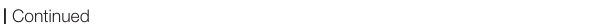
FIGURE 9 | Continued bilaterally directly before the start of light exposure (1st hour: PBS blue vs. yellow – q = 0.0008, p = 0.0008; oxybu blue vs. yellow – q < 0.0001, p < 0.0001; 3 h: PBS blue vs. yellow – q < 0.0001, p < 0.0001; oxybu blue vs. yellow – q = 0.0001, p = 0.0001). (B) Intraocular trigeminal afferents were anesthetized with lidocaine ( lido ). 2 µ L of drug was injected intravitreally ( ivt ) bilaterally 5 min before the start of light exposure (1st hour: PBS blue vs. yellow – q = 0.0007, p = 0.0006; 3 h: yellow PBS vs. lido – q = 0.0210, p = 0.0200; PBS blue vs. yellow – q = 0.0004, p = 0.0003). (C) Intraocular blood vessels were constricted with norepinephrine ( norip ). 2 µ L of drug was injected intravitreally ( ivt ) bilaterally 5 min before the start of light exposure (1st hour: PBS blue vs. yellow – q = 0.0003, p = 0.0003; norip blue vs. yellow – q < 0.0001, p < 0.0001; 3 h: PBS blue vs. yellow – q < 0.0001, p < 0.0001; norip blue vs. yellow – q < 0.0001, p < 0.0001). Blue and yellow bars correspond to blue and yellow exposures, respectively; clear bars and hatched bars correspond to animals with control (vehicle – PBS) or specific drug treatments, respectively. All the data are presented as mean ± SEM. Differences were considered significant when p < 0.05 ( ∗ / ∧ ), p < 0.01 ( ∗∗ / ∧∧ ), p < 0.001 ( ∗∗∗ / ∧∧∧ ) or p < 0.0001 ( ∗∗∗∗ / ∧∧∧∧ ). Stars correspond to comparisons between blue-illuminated and yellow-illuminated mice, treated with the same drug. Carets correspond to comparisons between control and drug-treated animals. Red color means increase and blue color decrease in values. For the results close to be significant, correspondent p - and q -values are marked on the graph.